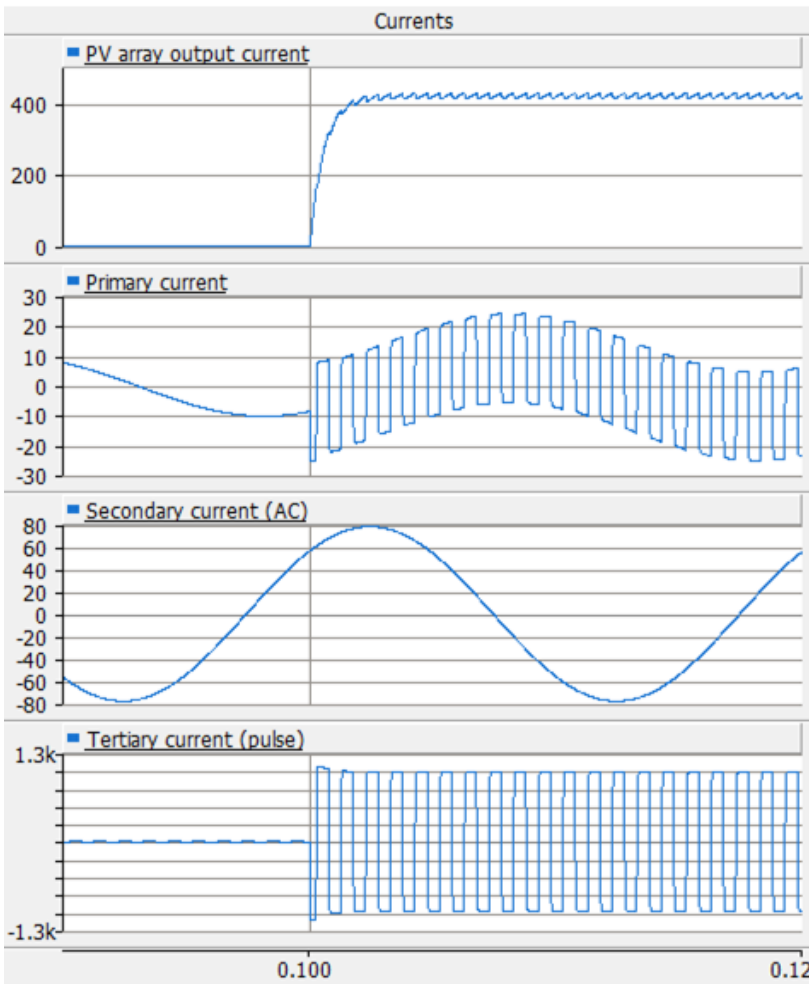
All currents are in A